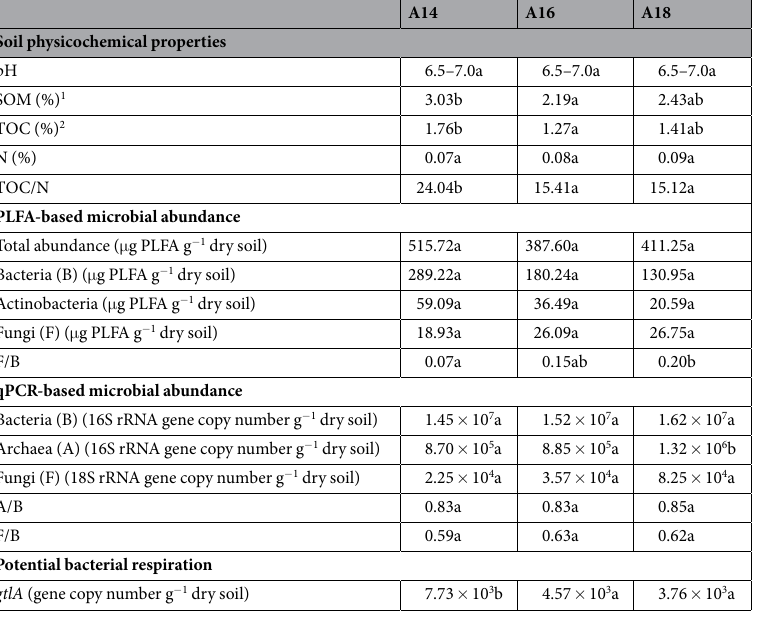
Table 1. Physicochemical properties, microbial abundances and potential bacterial respiration determined in soil samples of the studied layers A14 (upper), A16 (intermediate) and A18 (lower). For each variable, mean values followed by different letters are significantly different (p ≤ 0.05). 1 SOM, soil organic matter. 2 TOC, total organic